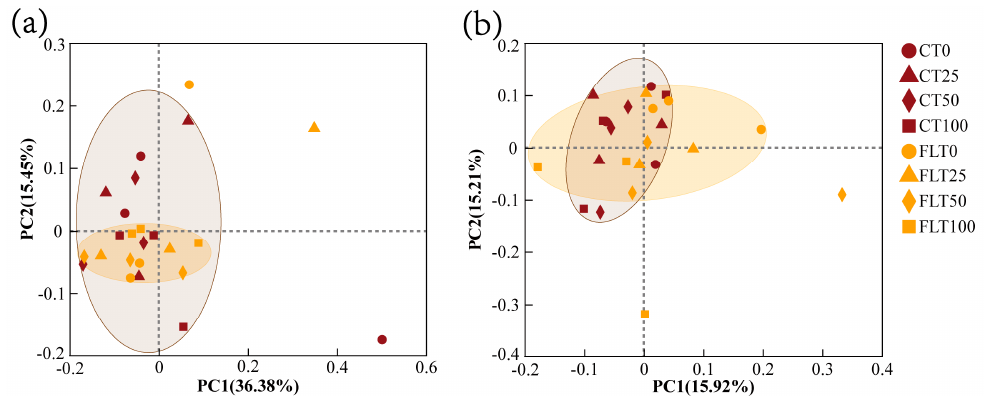
Figure 4. Scatter plots of principal coordinate analysis (PCoA) ordering of cassava rhizosphere soil fungal communities at OUT level based on Bray–Curtis phylogenetic distance (( a ) 2019; ( b ) 2020).